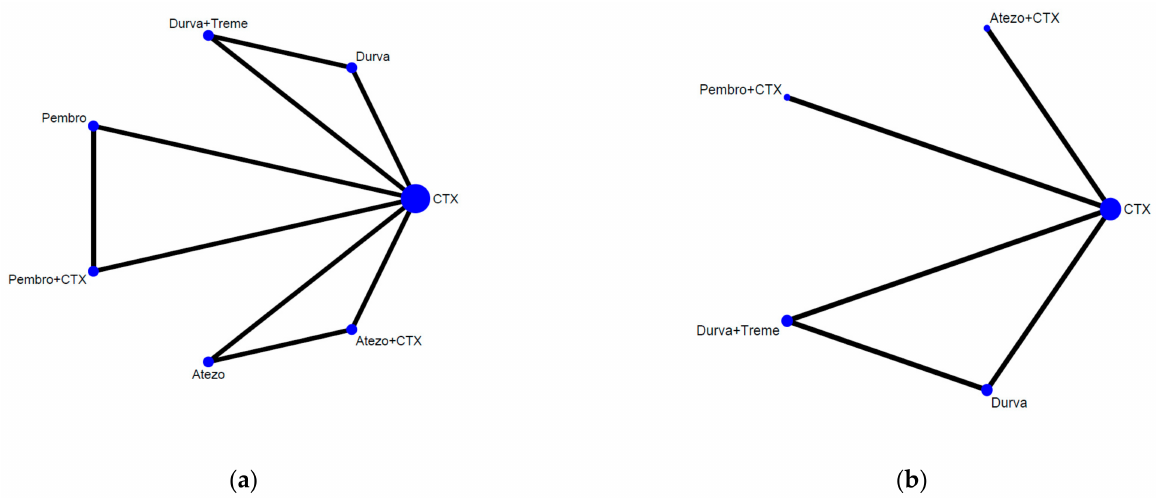
Figure 2. Network constructions for comparison in overall survival (OS), progression of free survival (PFS), objective response rate (ORR), and grade 3–5 adverse events (AEs). ( a ) Network constructions for comparison in OS (hazard ratio (HR)), ORR, grade 3-5 AEs. ( b ) Network constructions for comparison in PFS